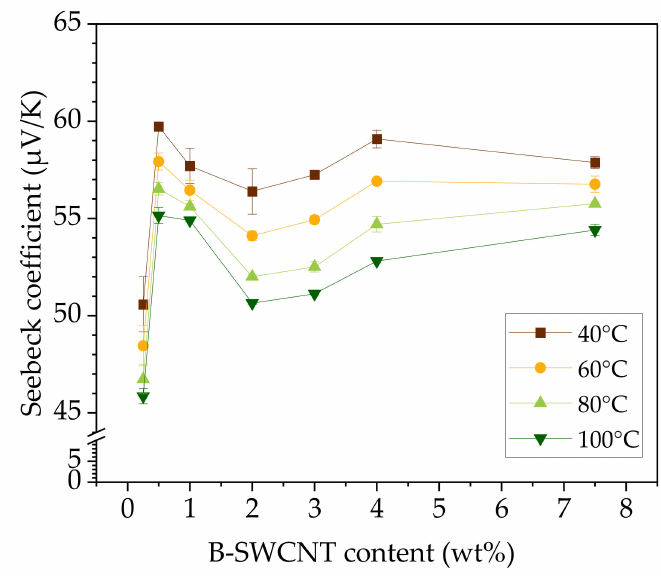
Figure 3. Seebeck coe ffi cient at di ff erent measuring temperatures for polypropylene (PP) / B-SWCNT